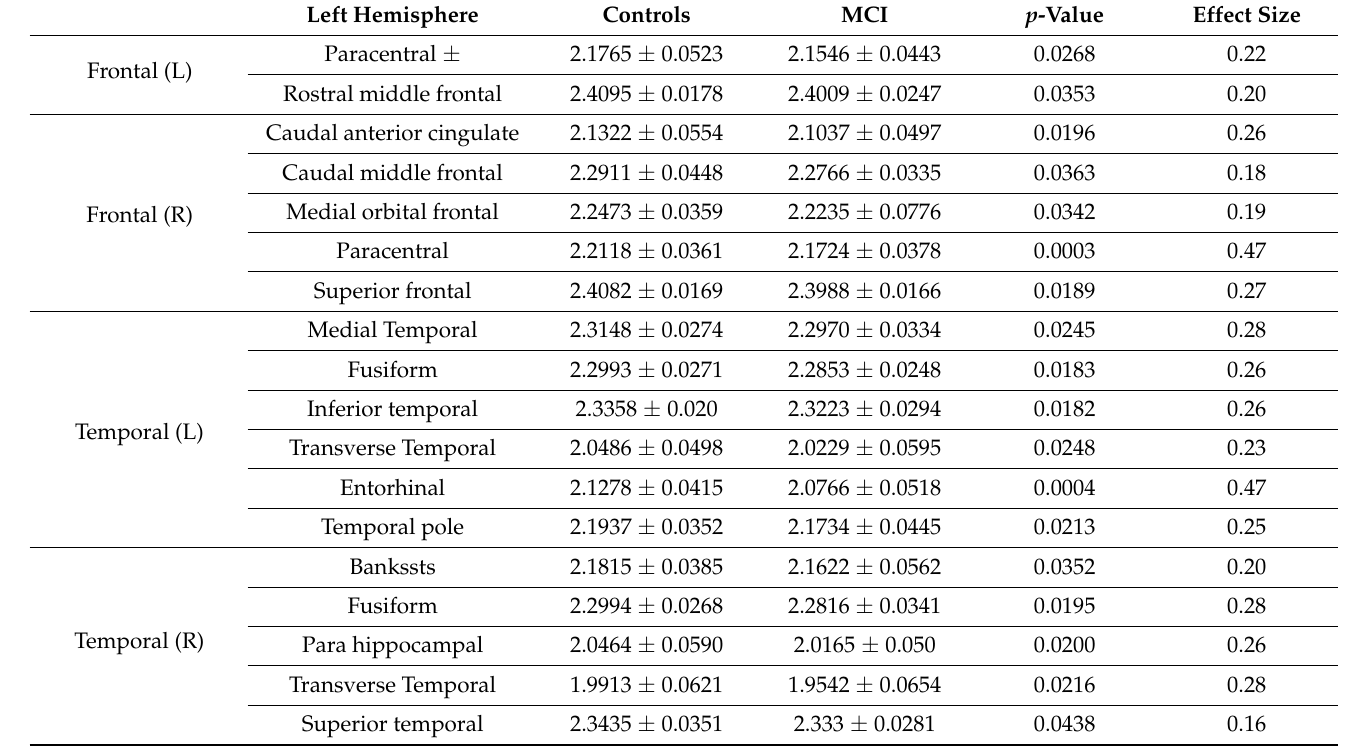
Table 4. Cortical subregions of significantly decreased FD values in the MCI